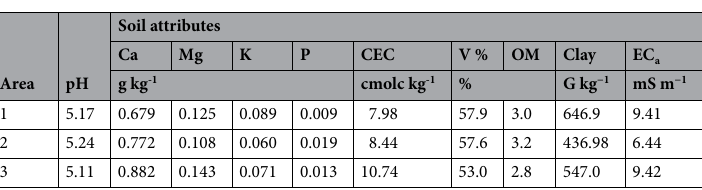
Table 1. Means of soil attributes in the experimental areas obtained from a total of 300 sampling points. Ca, calcium; Mg, magnesium; CEC, cation exchange capacity; K, potassium; P, phosphorus; V%, base saturation; OM, organic matter; Clay, clay content; EC a , soil apparent electrical